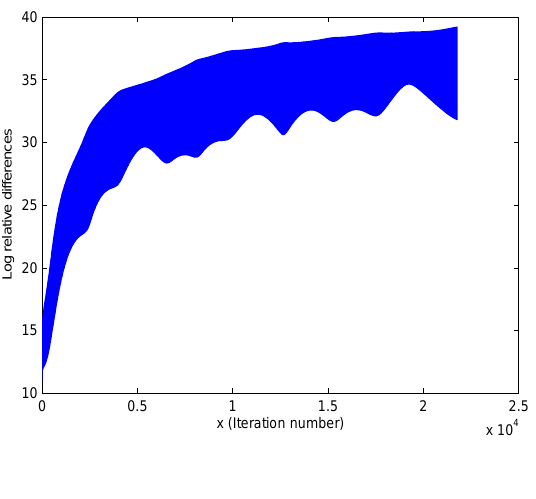
Figure 8. Example of simultaneous